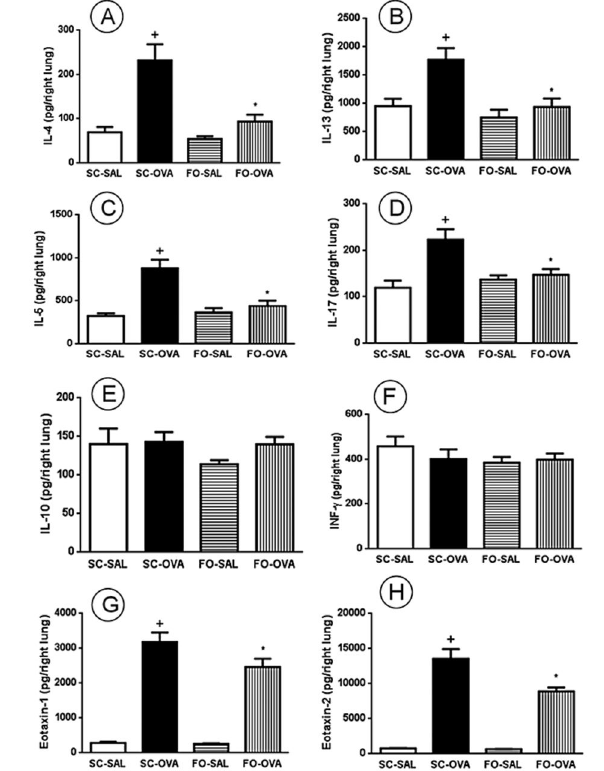
Figure 7. Effect of FO intake on allergen-induced IL-4 (A), IL-13 (B), IL-5 (C), IL-17 (D), IL-10 (E), INFγ (F), eotaxin-1 (G) -2 production (H), in the lung tissue of A/J mice, 24 hours after the last challenge. Sensitized, saline-challenged (SC- SAL); sensitized, ovalbumin-challenged (SC-OVA); sensitized, saline-challenged given fish oil (FO-SAL) and sensitized, ovalbumin-challenged with fish oil (FO-OVA). In the signaled cases, P <0.05 compared with the SC-SAL group (+) and the SC-OVA group (*) (one-way ANOVA and post-hoc Holm-Sidak test). Values are the means ± S.E.M. and are representative of 1 experiment (n=7 per